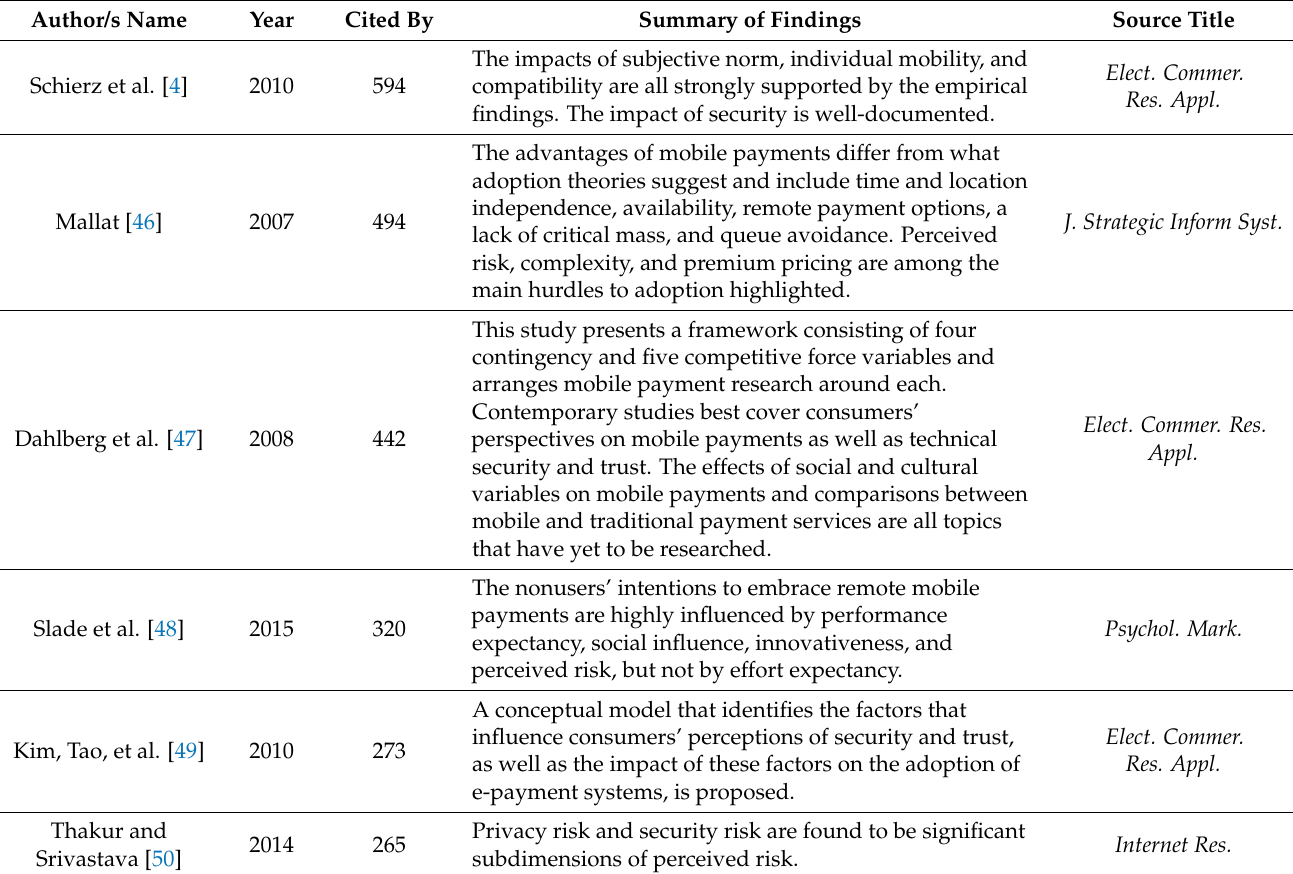
Table 4. The most influential studies based on citation